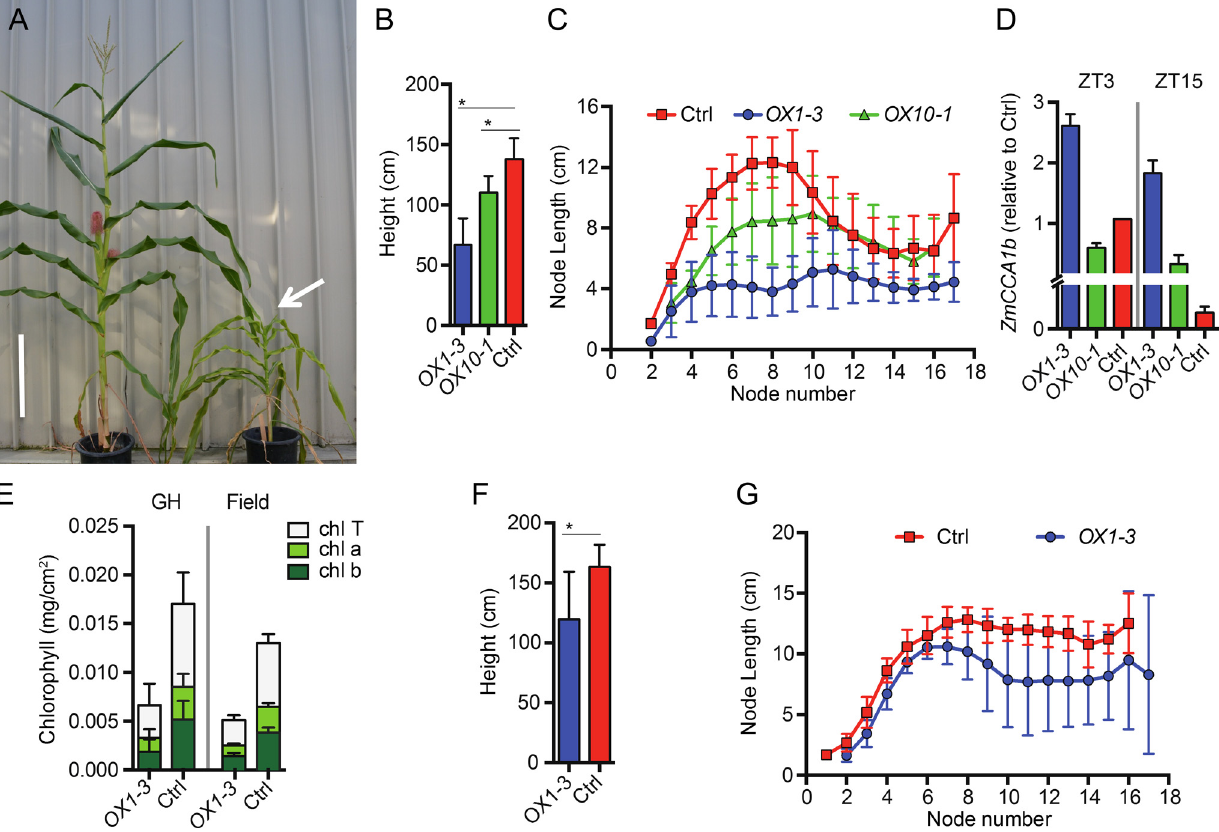
Fig 4. Maize transgenic plants that overexpressed ZmCCA1b ( OX1-3 and OX10-1 ). (A) Phenotypes of OX1-3 and control lines grown in a greenhouse (an arrow indicates the reduced height in OX1-3 ). Scale bar = 40 cm. (B) Height at maturity for OX1-3 , OX10-1 , and control plants grown in the greenhouse. (C) Measurement of node elongation for OX1-3 , OX10-1 , and control plants grown in the greenhouse (n = 10, ± SD). (D) Relative expression levels (to the control, Ctrl, at ZT3) of ZmCCA1b in the leaves of OX1-3 and OX1-10 transgenic plants at ZT3 and ZT15 (n = 2, ± SD). Significant difference was calculated using Student ’ s t-test, * p-value < 0.001. (E) Chlorophyll a (chl a), chlorophyll b (chl b), and total chlorophyll (chl T) content in leaves of OX1-3 and control plants grown in the greenhouse (GH) or field as indicted. Chlorophyll measurements for greenhouse grown and field-grown plants should not be compared since different developmental stages were tested between the two growth conditions. Greenhouse-grown plants were at stage V9 and field-grown plants were at maturity. (F) Height at maturity for OX1-3 and control plants grown in the field. Significant difference was calculated using Student ’ s t-test, * p-value < 0.001. (G) Measurement of node elongation for OX1-3 and control plants grown in the field (n = 10, ±